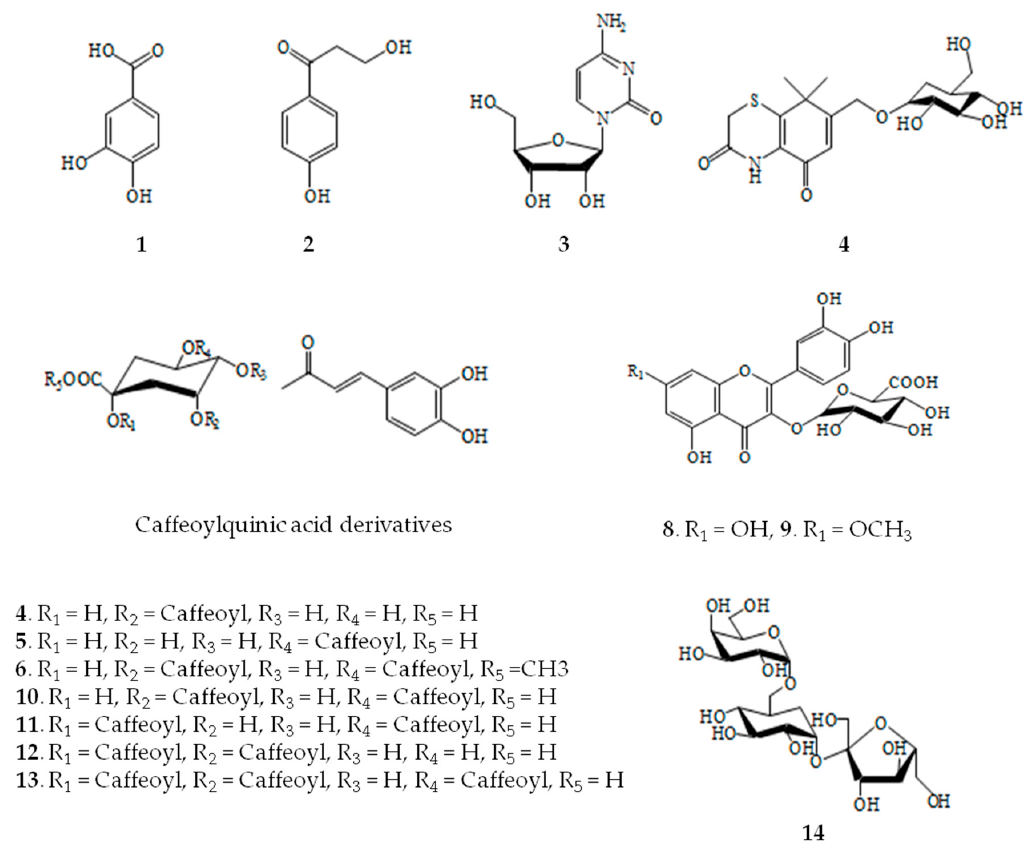
Figure 2. Structures of compounds isolated from X . strumarium .